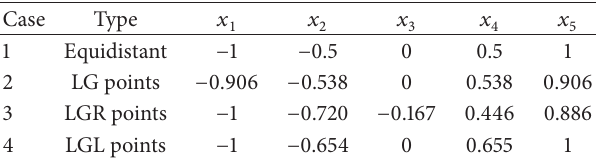
Figure 5: Formulation of the collocation constraints in the pseu- dospectral method.